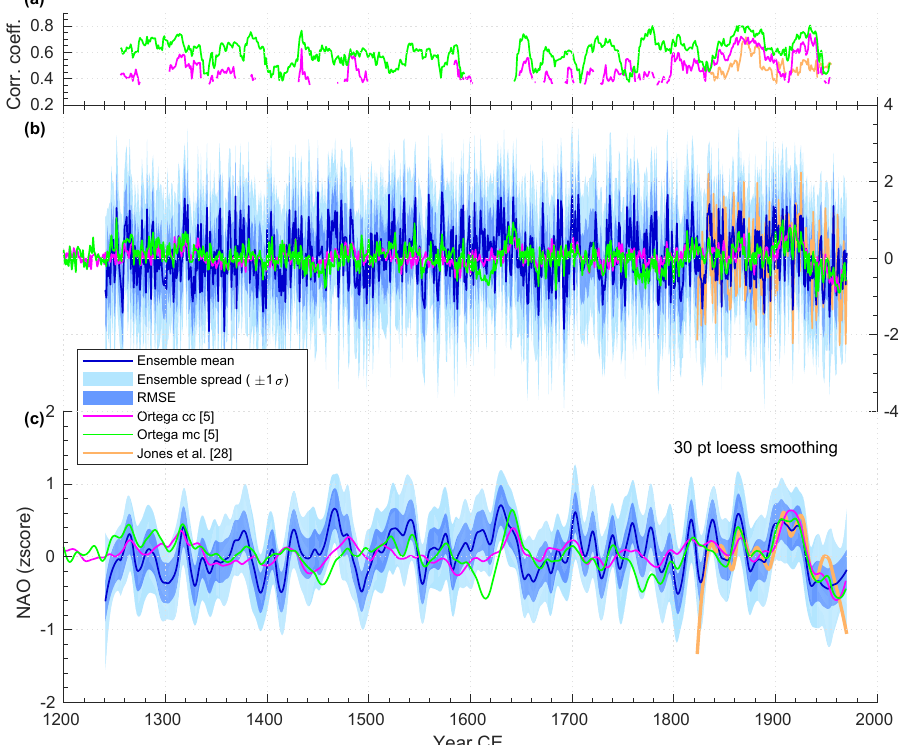
Figure 3. Comparison of instrumental NAO and proxy-based NAO reconstructions. (a) Moving 31-point correlation between reconstructed NAO from this study and NAOcc (magenta), NAOmc (green; Ortega et al., 2015) and observed NAO (yellow; Jones et al., 1997). Only significant correlations are plotted ( p < 0 . 05). (a) Ensemble mean reconstructed NAO (PC1 of reconstructed SLP Hurrell et al., 2003) with error estimated by ensemble spread and RMSE, compared to observed NAO (Jones et al., 1997) and NAO reconstructions by Ortega et al. (2015). The amplitude of all time series are scaled to fit the decadal variability in the observed NAO. (c) Same as (b) , except filtered with a 30 point “loess”